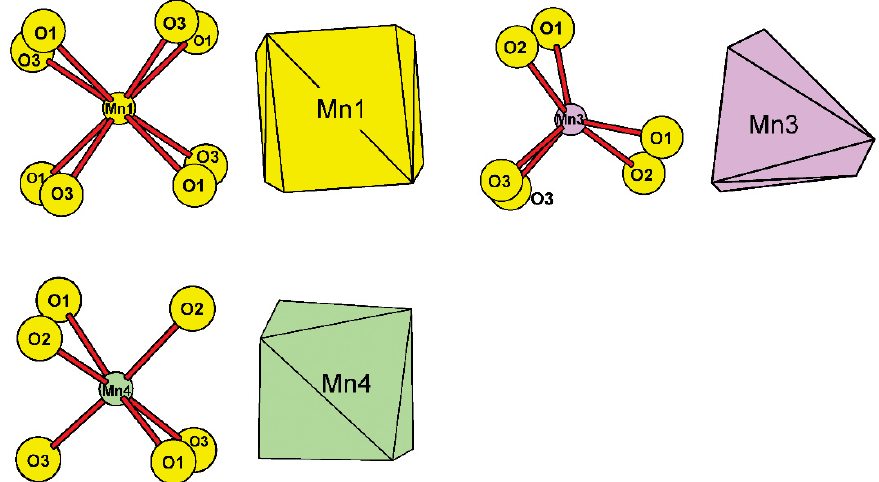
Figure 1. Coordination of Mn1, Mn3 and Mn4 polyhedra.